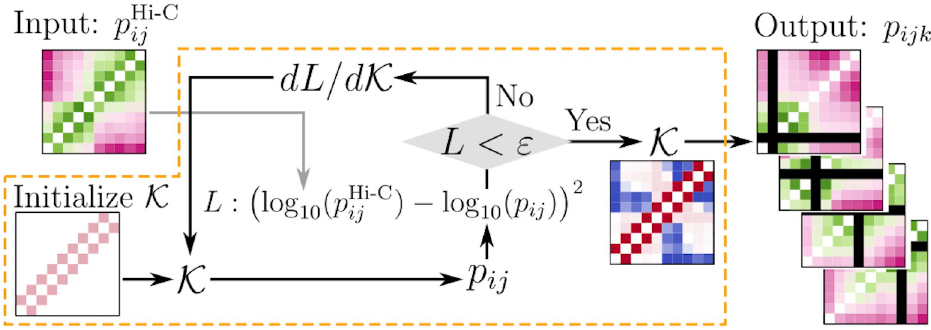
Fig 2. Flow chart of HLM that is enclosed by the dashed orange box. It takes two-body contacts from Hi-C as input, and calculates n -body ( n > 2) contact probability. The stiffness matrix K is updated until the algorithm finds K � that minimizes the cost function L ¼ L ð K Þ which quantifies the difference between pairwise contact probabilities of Hi-C data and those determined from K matrix.